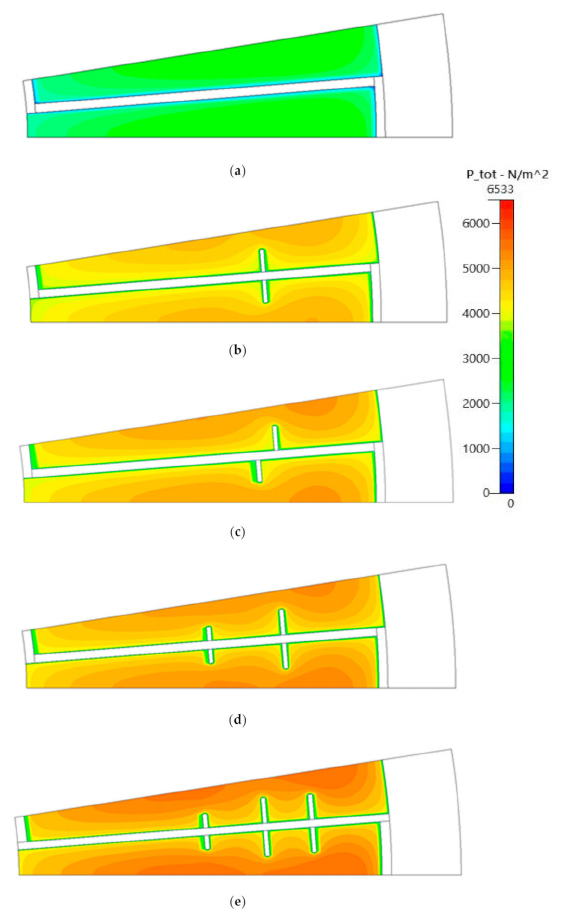
Figure 9. The comparisons of pressure distributions for ( a ) PTHE-Z, ( b ) design A ( c ) design B ( d ) design C and ( e ) design D at z = 100